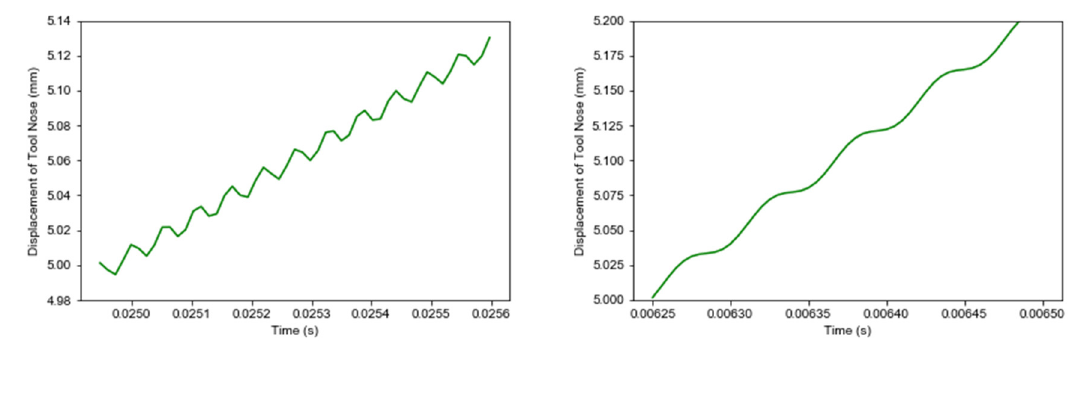
Figure 9. Displacement trajectory of the tool tip. ( a ) 200 mm/s; ( b ) 800 mm/s.